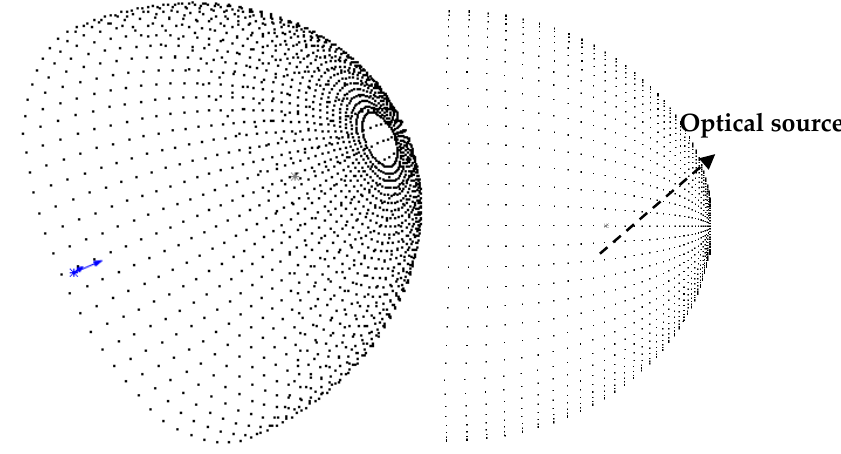
Figure 6. Generated discrete points of a freeform surface at different projections.